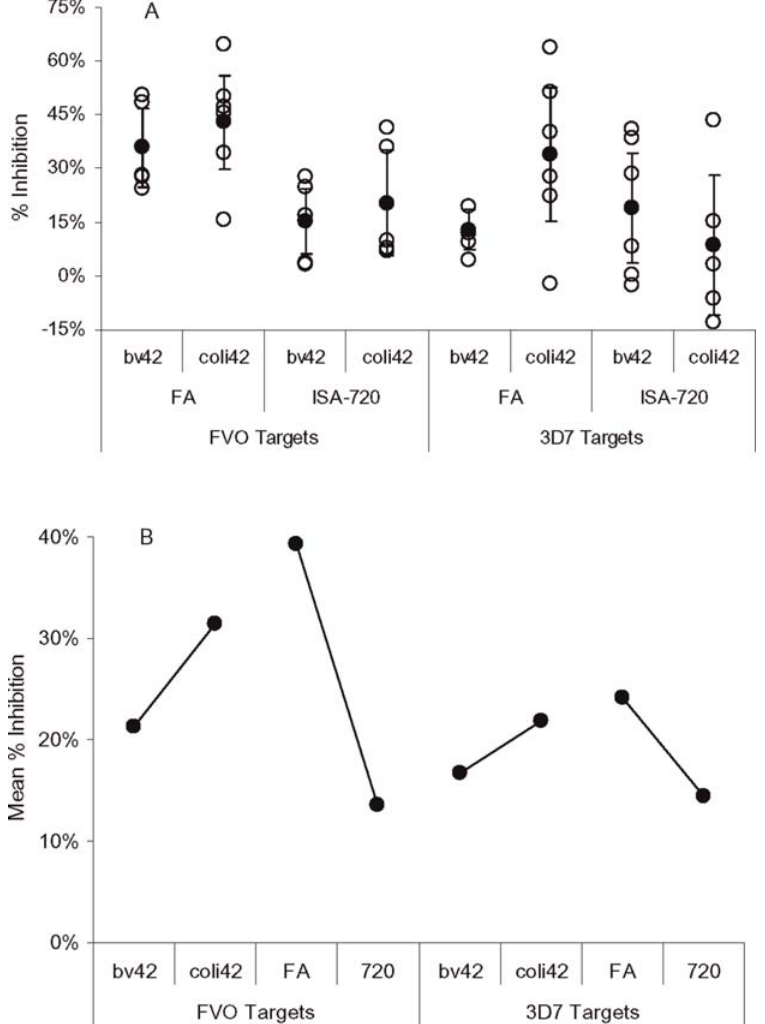
Figure 3. Growth/invasion inhibition for regimens 3, 7, 8, and 9 grouped by adjuvant and antigen. Open circles, individual responses; filled circles, means; bar is the 95% confidence interval for the mean. Panel A compares grouped %Inhibition levels. Panel B shows the estimated marginal means from the GLM used to analyze the responses.